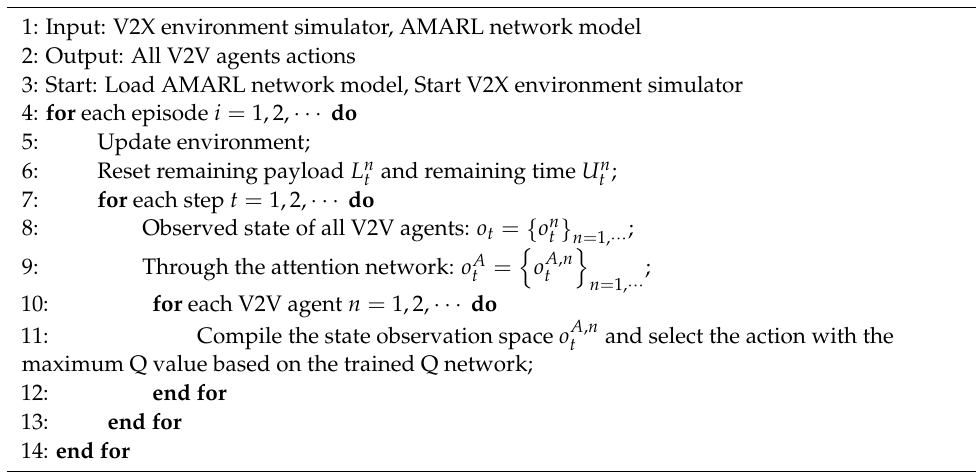
Algorithm 2 Testing Process